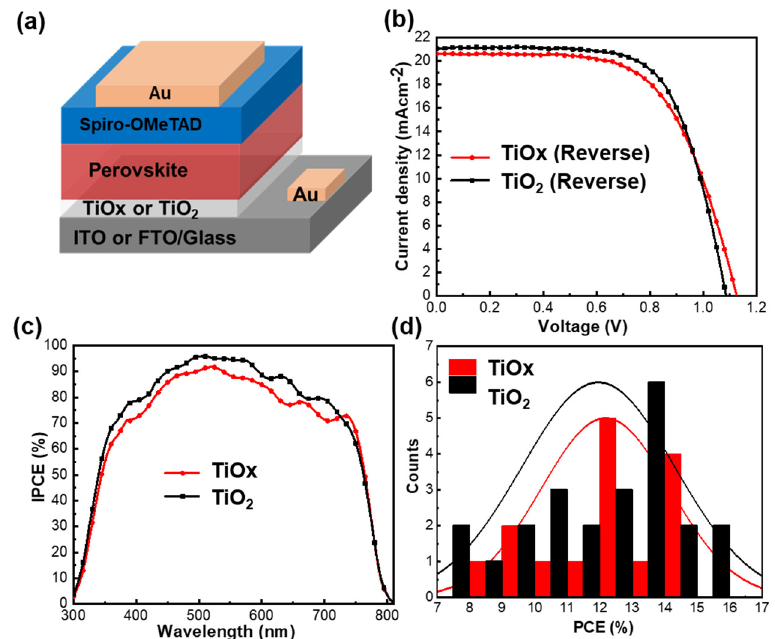
Figure 6. ( a ) Schematic of the complete device configuration, ( b ) reverse scan J–V curves of the TiO x - and TiO 2 -based PSCs, ( c ) incident photon-to-conversion efficiency (IPCE) spectra of the TiO x - and TiO 2 -based PSCs, and ( d ) histogram of the power conversation efficiencies (PCE) of PSCs with the TiO x and TiO 2 films.